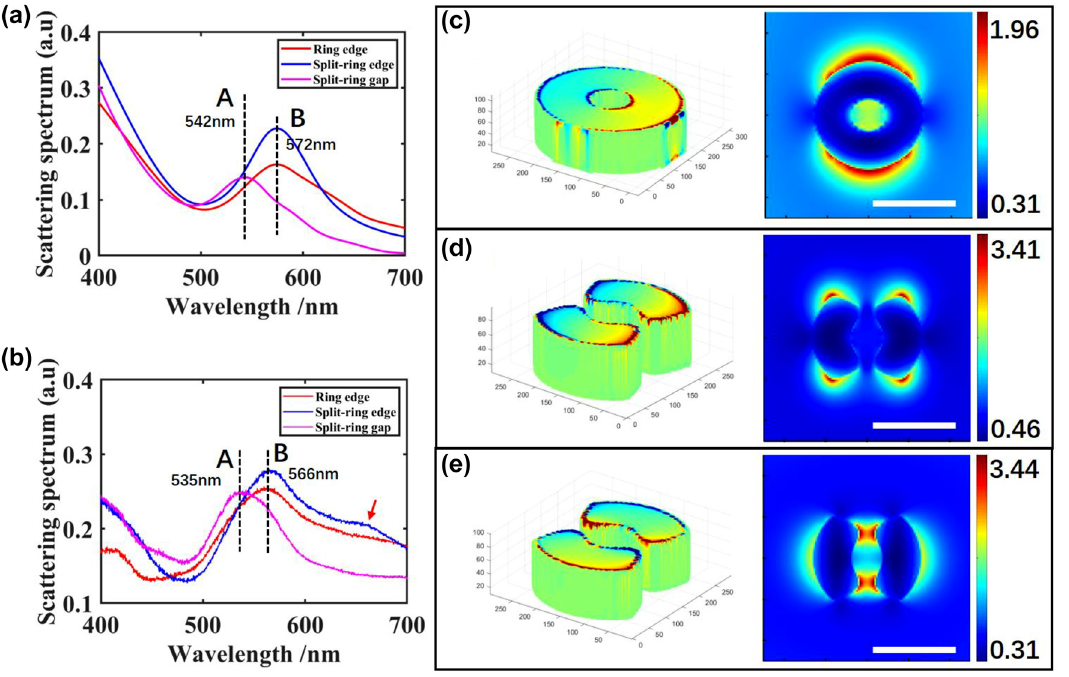
Figure 3: Scattering spectrums of plasmonic modes for (a) simulation and (b) experiment. Surface charge distribution and electric field distribution for (c) ring edge mode, (d) split-ring edge mode, and (e) split-ring gap mode. Scale bar: 200